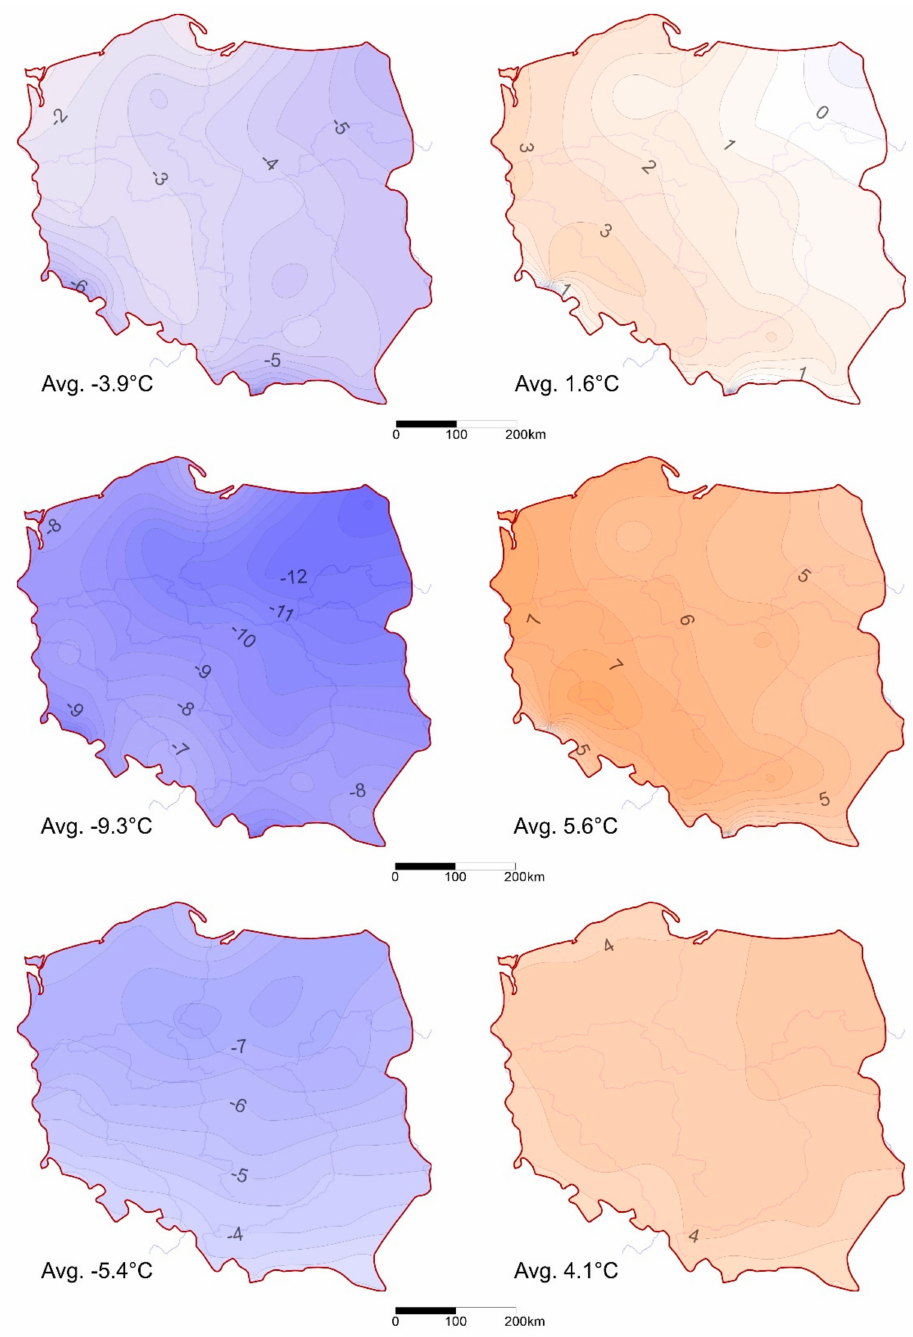
Figure 2. Mean Tmin and Tmax in winter in the years 1966/67–2019/20 ( top row ), mean Tmin and Tmax in winter of (respectively) 1969/70 and 2019/20 ( middle row ), and Tmin and Tmax anomalies during those winters ( bottom row ). Left column—Tmin, right